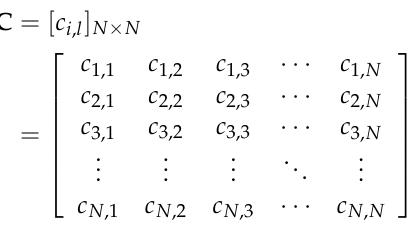
] = [ z ] T N × 1 1 , z 2 , z 3 , . . . , z N l l and z m